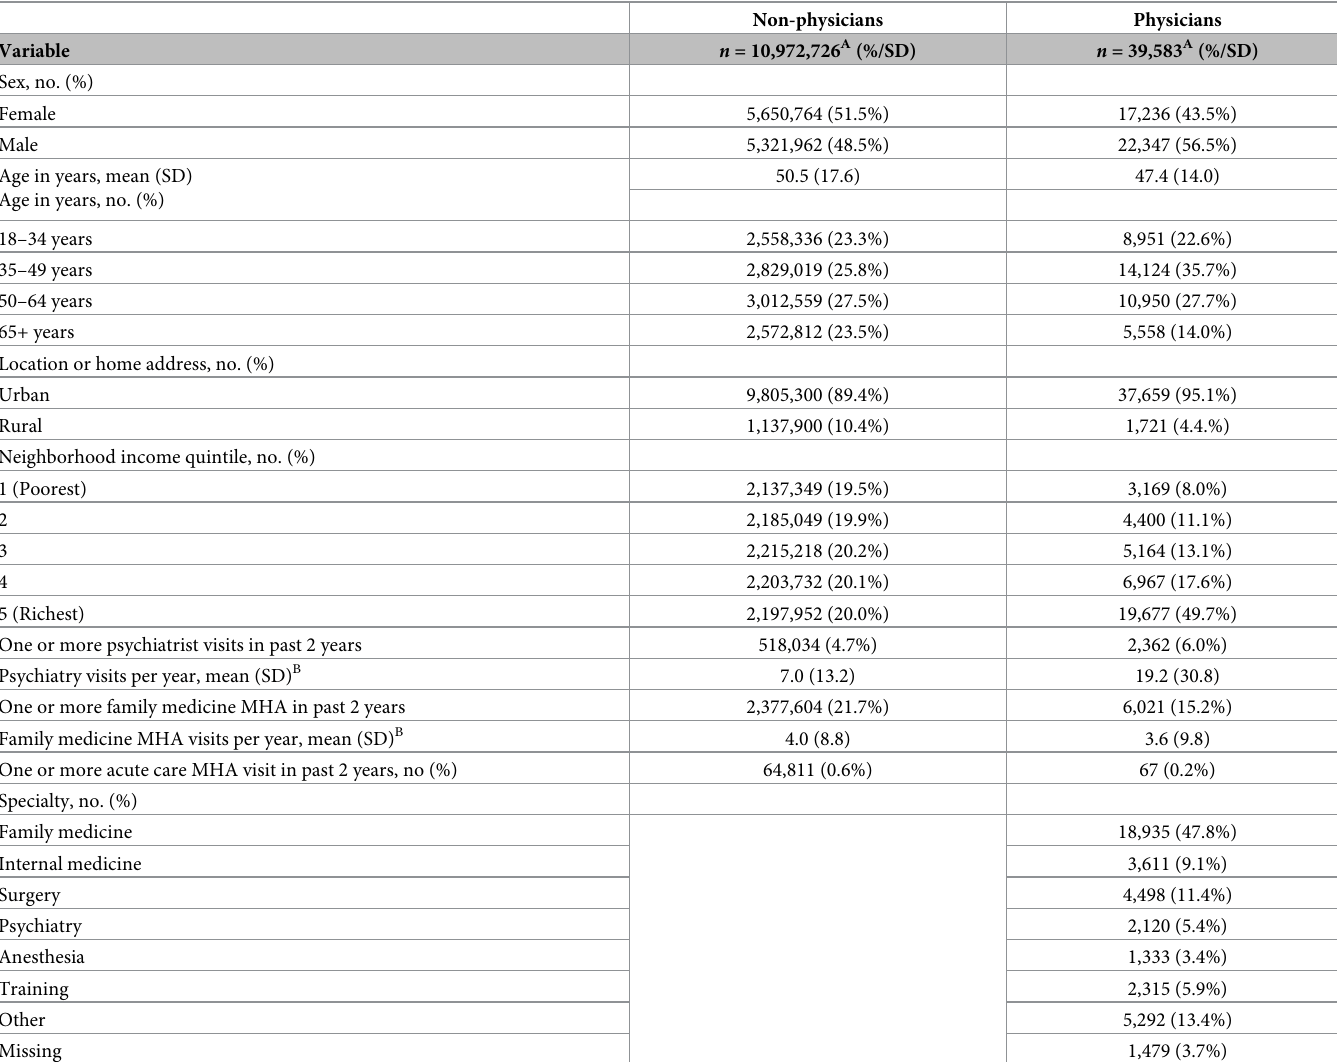
Table 1. Characteristics of physician and non–physicians on March 11,